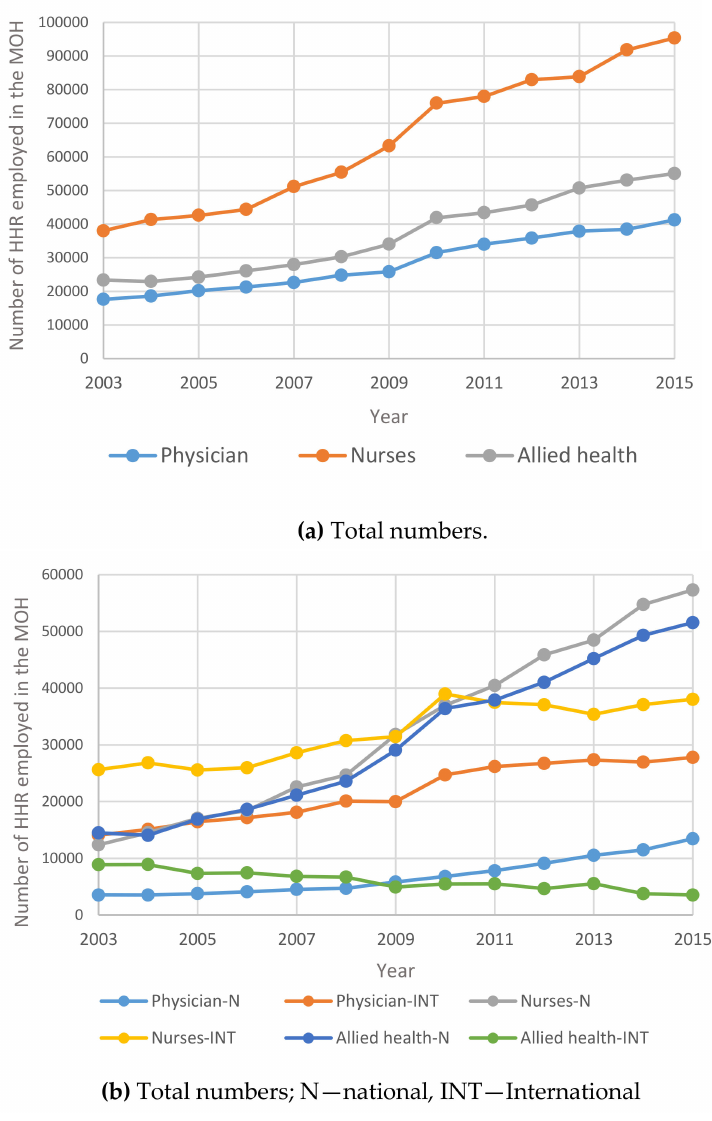
Figure 1. Time Series for HHR in the MOH between 2003 and 2015: ( a ) total numbers; ( b ) total numbers; N—national;